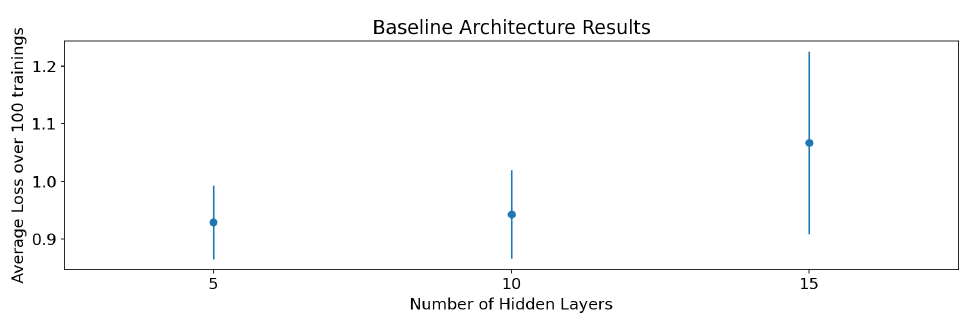
Figure 4. Baseline architecture final results. Best performing and most stable architecture is the one with 5 hidden layers.